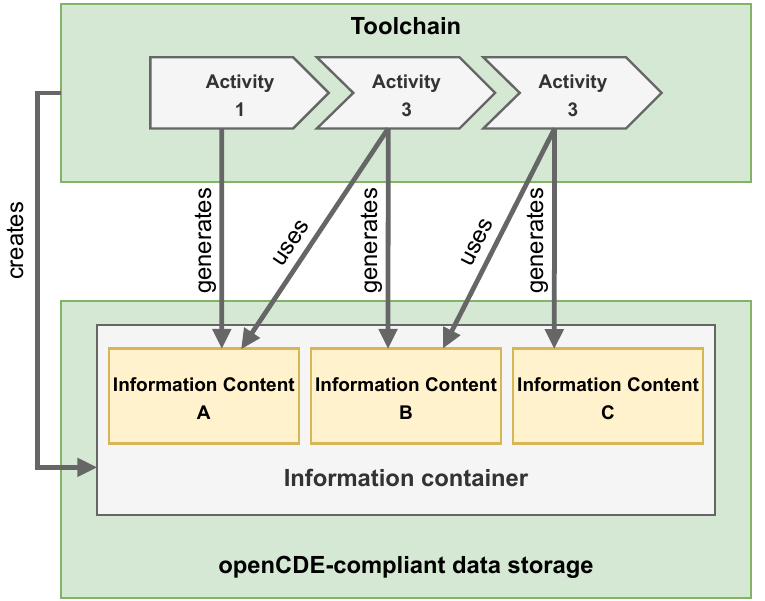
Figure 5. Relationship between toolchain and data management using the open CDE-compliant web